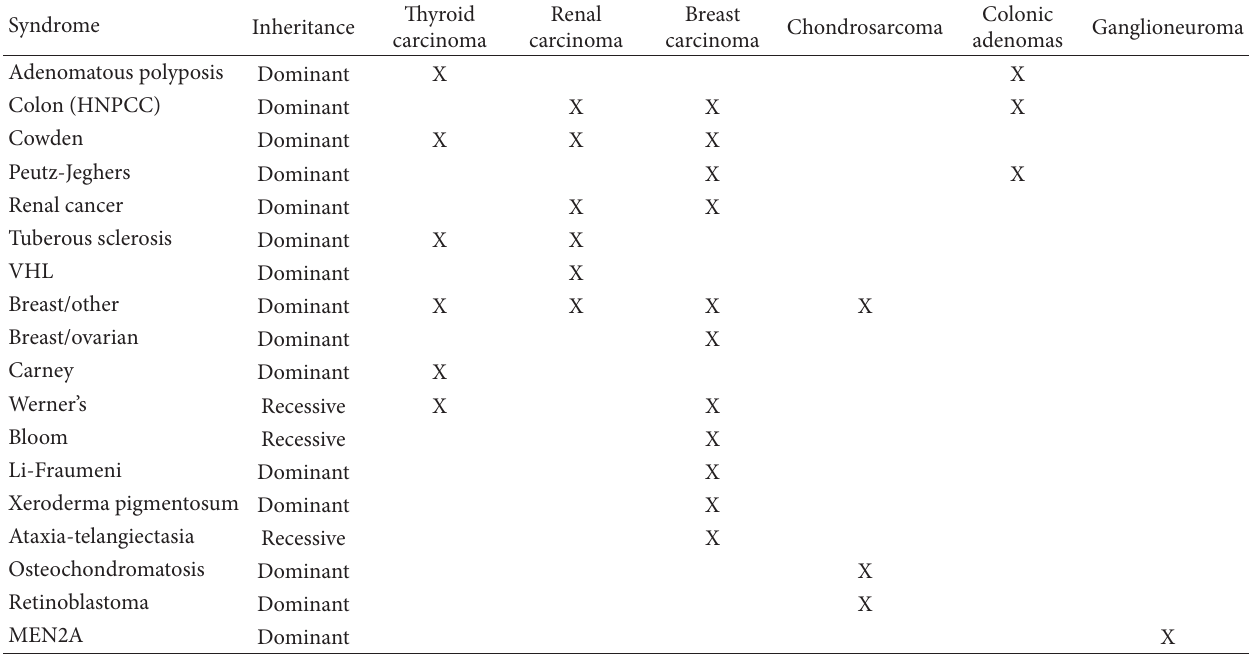
Table 1: Most common reported cancer syndromes with one or more components from the presented case.